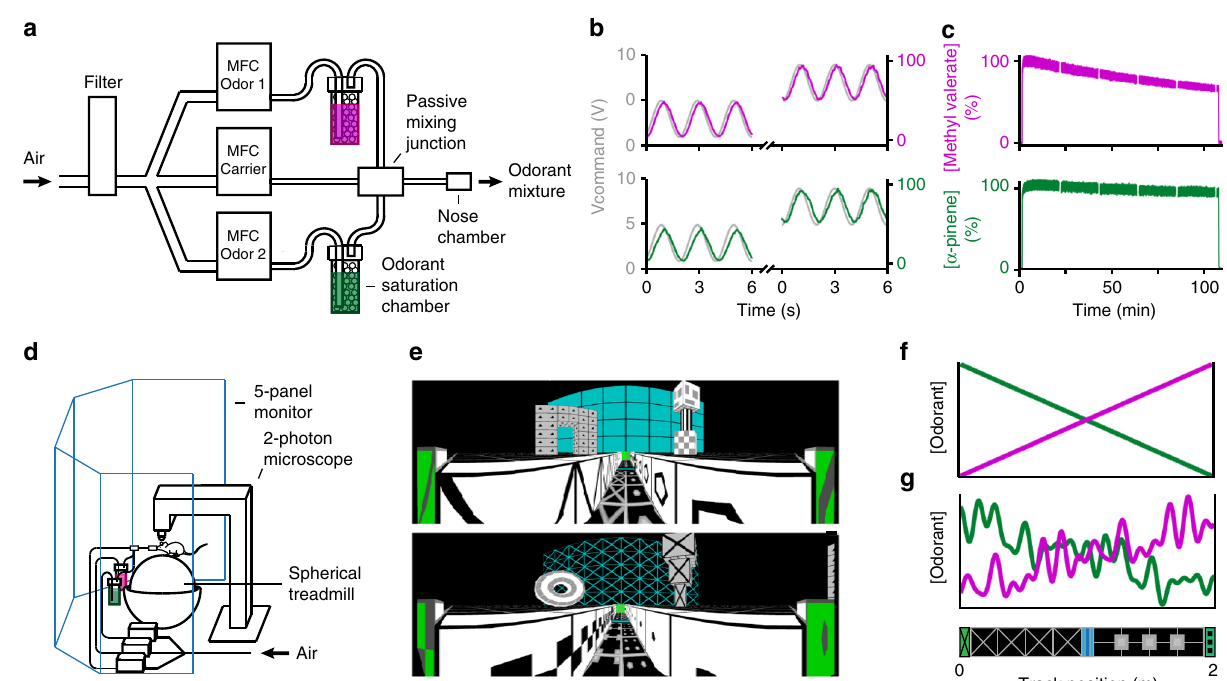
Fig. 1 Odorant delivery in VR. a Two mass fl ow controllers (MFCs) in parallel sent odorants to the nose. The odorants were methyl valerate (bubblegum smell, pink) and α -pinene (pine smell, green). A third MFC sending blank air was dynamically updated to maintain a constant fi nal fl ow rate (1 L min − 1 ). The three streams converged at a passive mixing block and fl owed to a nose chamber that covered the snout of the mouse (Supplementary Fig. 1). b Rapid, continuous odorant delivery following a 0.5-Hz sinusoidal command of low and high offset. Relative odorant concentration was measured using a photo- ionization detector (PID) placed at the nose chamber. c Stable odorant delivery at maximum fl ow rate (0.1 L min − 1 ) for ~100 min measured with PID at nose chamber. Small gaps occur where baseline measurements were taken to calibrate the PID (Supplementary Fig. 2). d The odorant delivery apparatus incorporated into an existing visual VR system in which a head- fi xed mouse ran on a spherical treadmill facing a 5-panel monitor beneath a 2-photon microscope. e Top: view from the α -pinene side of the track. Bottom: view from the methyl valerate side of the track. f Idealized smooth odorant spatial distributions. g Idealized example noisy odorant spatial distributions (top). Cartoon of the visual virtual track